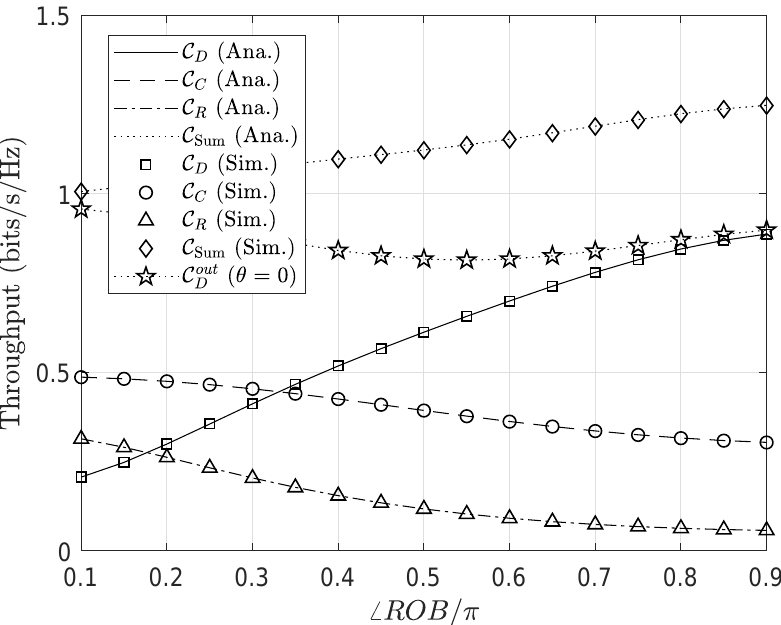
Figure 9. Throughput performance versus the normalized angle (cid:54) ROB